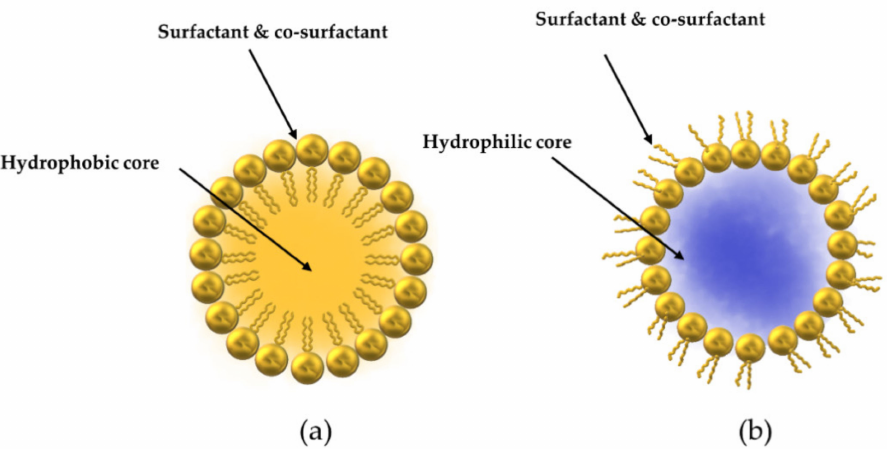
Figure 8. Schematic illustration of ( a ) O/W microemulsion system, ( b ) W/O microemulsion system. Two major categories of preparation methods are employed to form